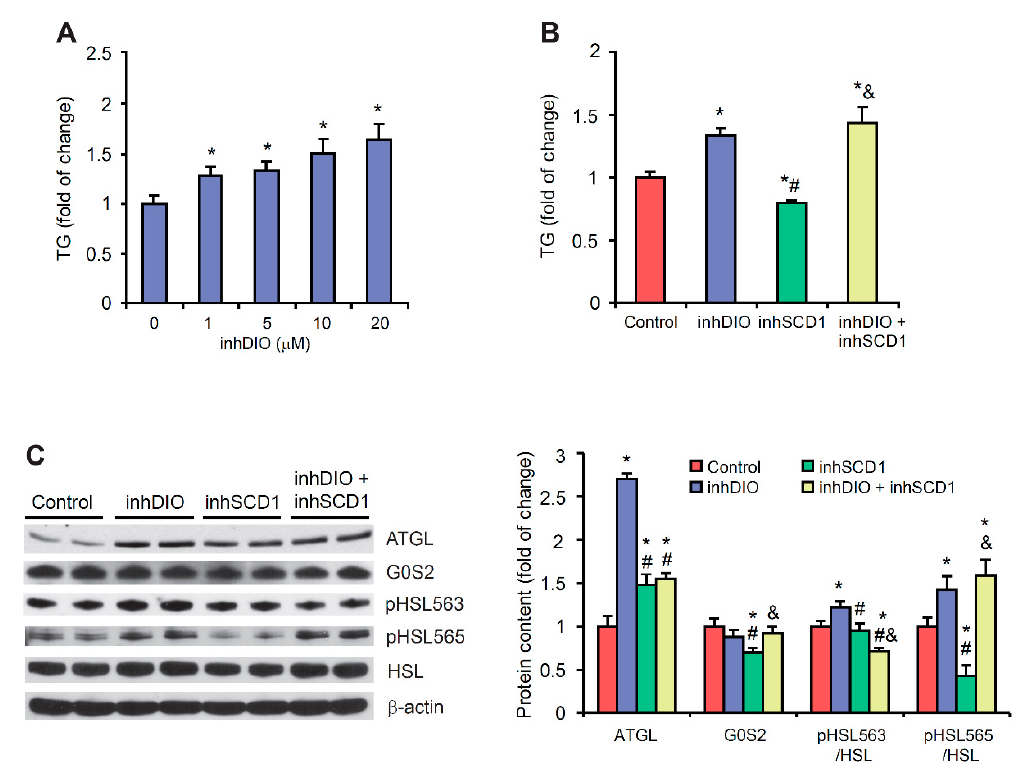
Figure 6. ( A , B ) Effect of DIO inhibitor iopanoic acid (inhDIO) and SCD1 inhibitor A939572 (inhSCD1) on triglyceride (TG) content in HL-1 cardiomyocytes. Cells were harvested, and lipid extracts were separated by thin-layer chromatography. The plate was then soaked in a water mixture that contained cupric sulfate and phosphoric acid and charred. Lipids were then quantified by densitometry. ( C ) Protein levels of adipose triglyceride lipase (ATGL), G 0 /G 1 switch protein 2 (G0S2), hormone-sensitive lipase (HSL), and phosphorylated HSL (pHSL) at Ser563 and Ser565 in HL-1 cardiomyocytes that were treated with the inhDIO and/or inhSCD1. The data are representative of three independent experiments. * p < 0.05, vs. control; # p < 0.05, vs. inhDio; & p < 0.05, vs. inhSCD1.